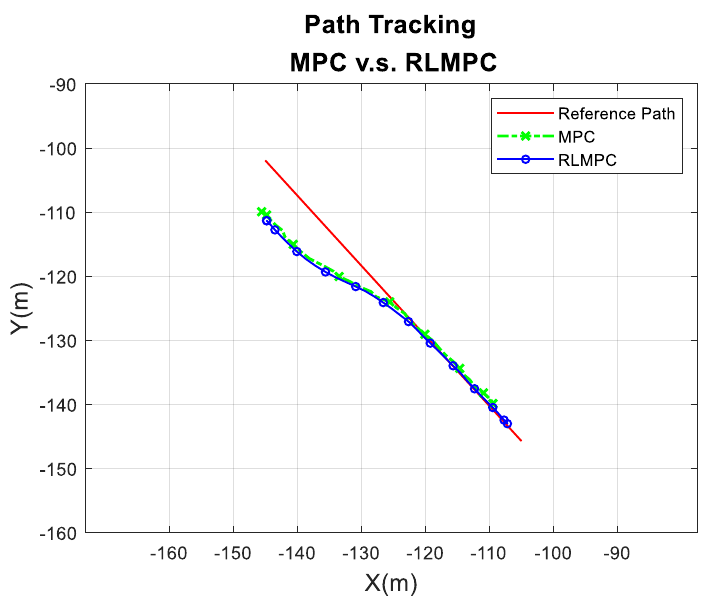
Figure 10. Trajectory comparison of MPC and RLMPC in scenario 1.